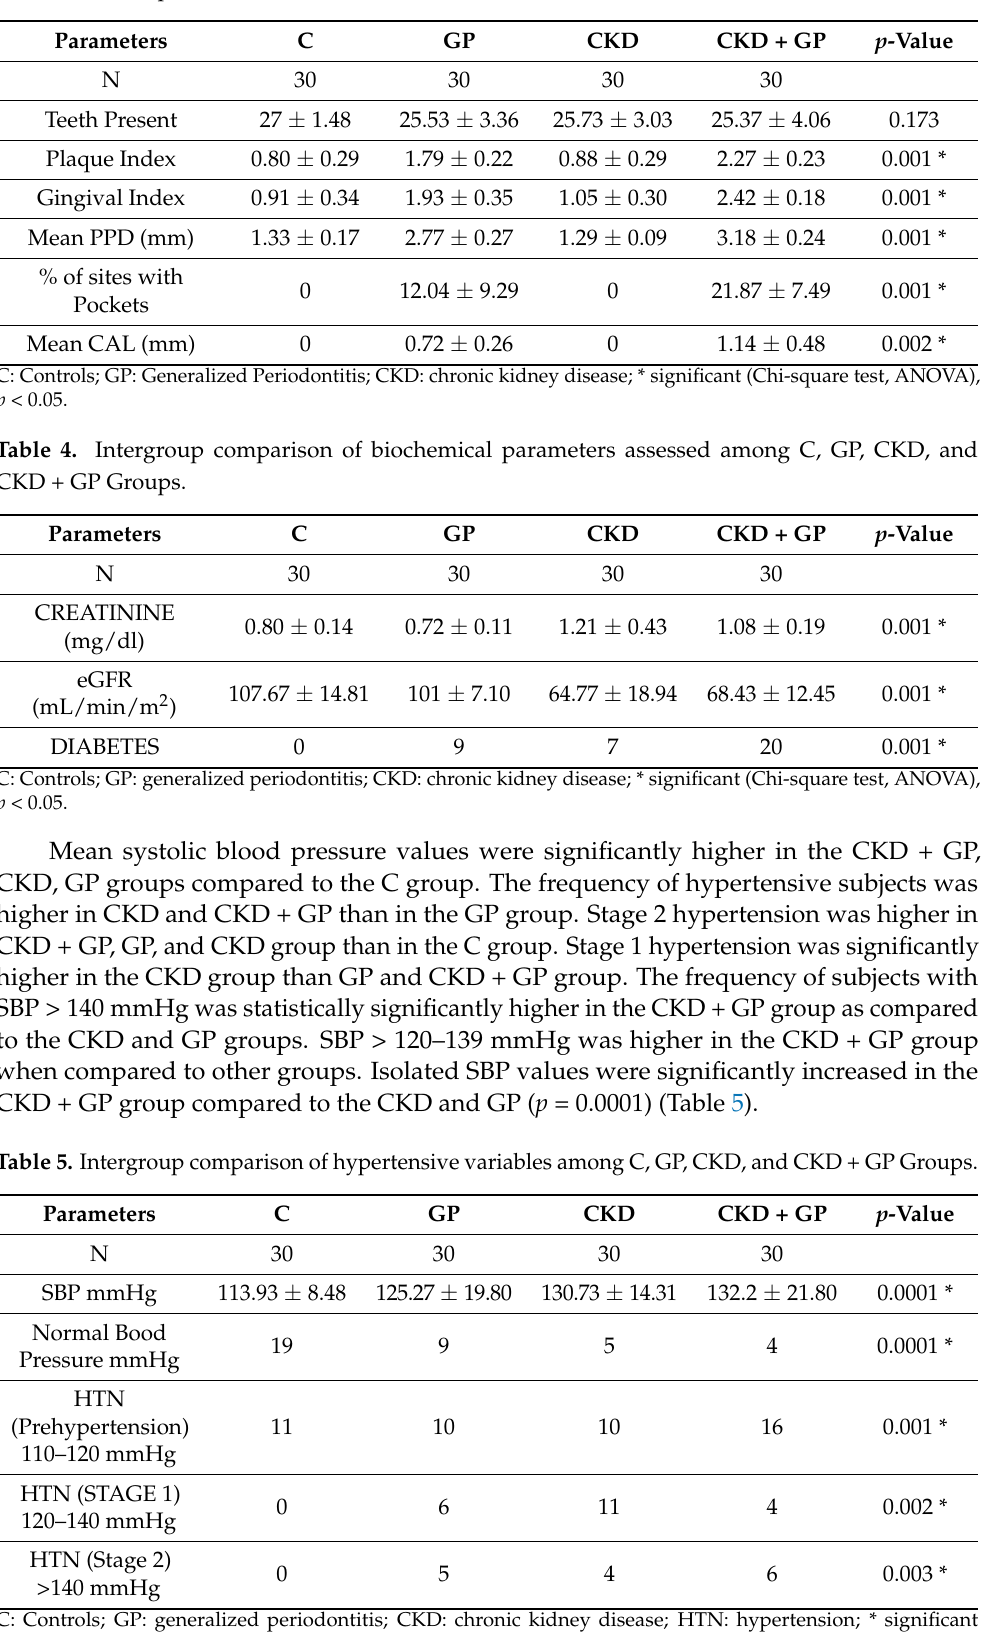
Table 3. Intergroup comparison of periodontal parameters assessed among C, GP, CKD, and CKD + GP Groups.